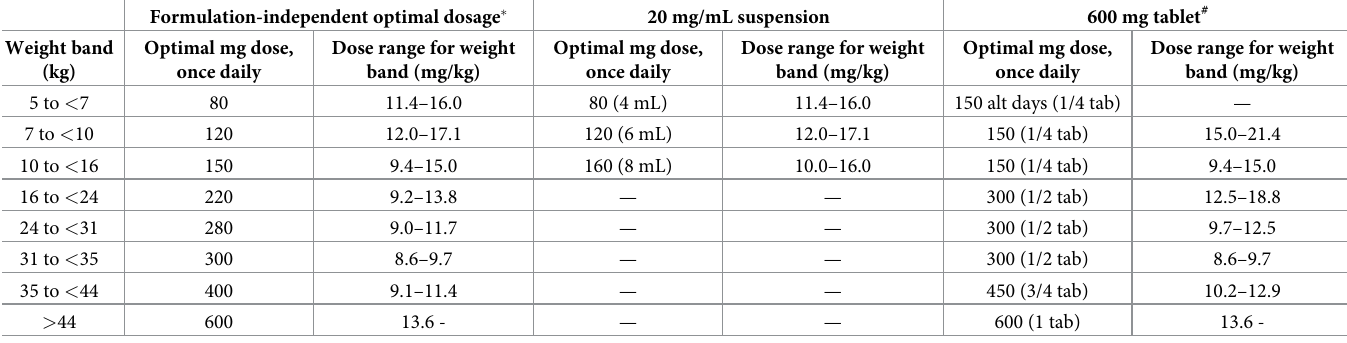
Table 4. Proposed weight-banded once-daily doses of linezolid for children treated for MDR-TB approximating the exposure in adults receiving a 600 mg once- daily dose (AUC 0–24ss 110 mg .